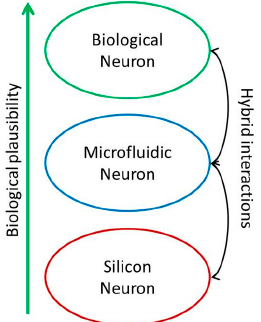
Figure 1. Microfluidic neuron position in the biocompatibility neuron modelling for hybrid experiments.